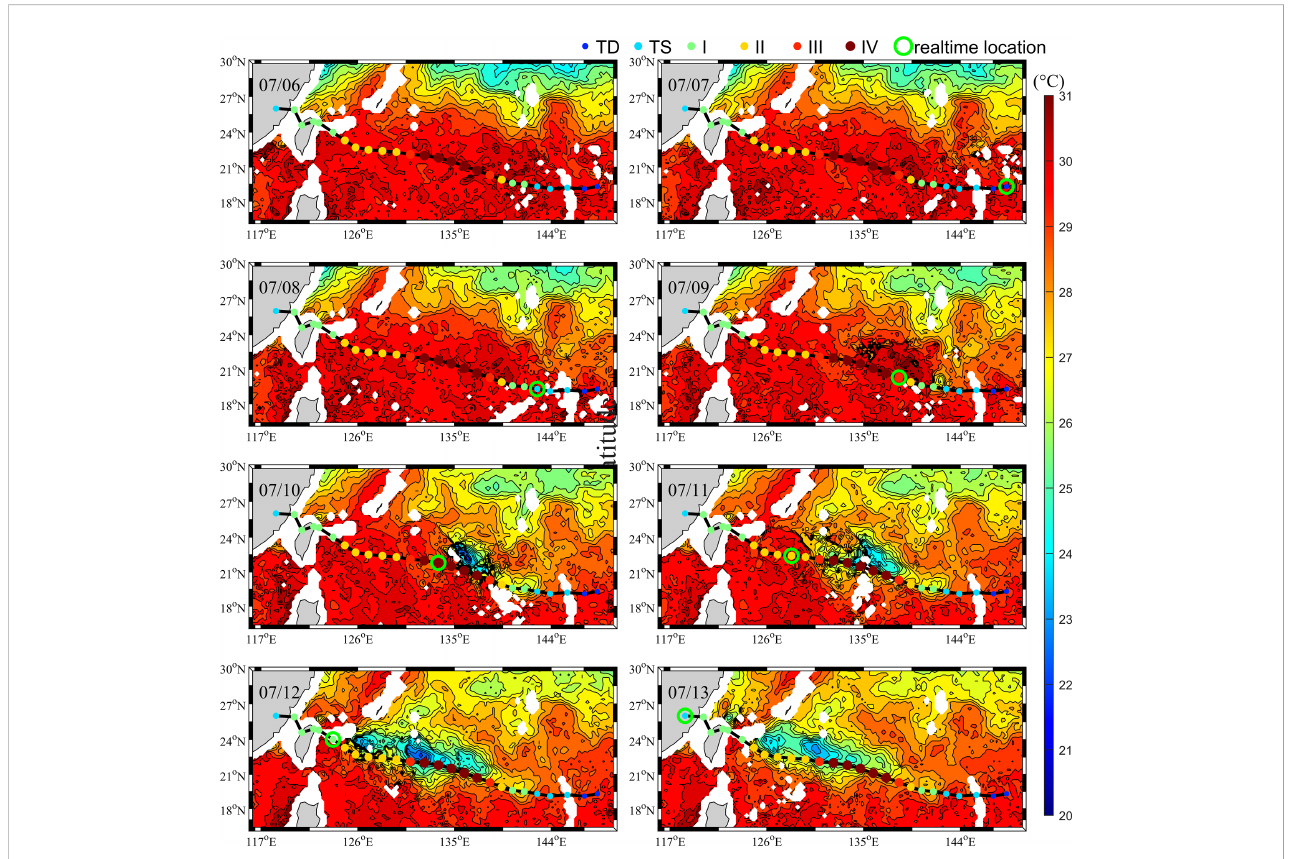
FIGURE 3 Remote sensing SST observations from July 6 to July 13, 2013. Colored dots show the intensities and locations of Typhoon Soulik (2013) at 6-hour time intervals. TD, TS, I, II, III and IV represent tropical depression, tropical storm, and category 1, category 2, category 3 and category 4 tropical cyclone grades, respectively, according to the Saf fi r-Simpson hurricane wind scale. The enlarged green circle is the real-time location of the typhoon center at 0000 UTC on each